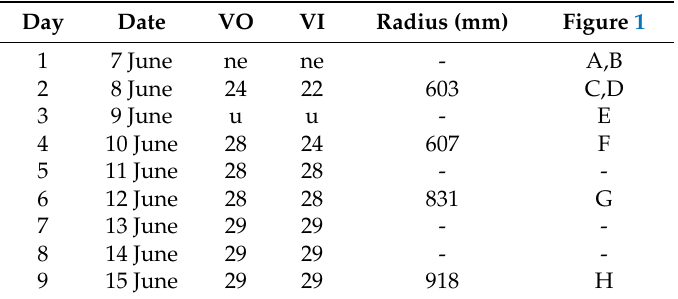
Table 1. Number of valleys detected from outside (VO) and from inside (VI) the structure and radius of a mystery circle constructed by the pufferfish Torquigener albomaculosus